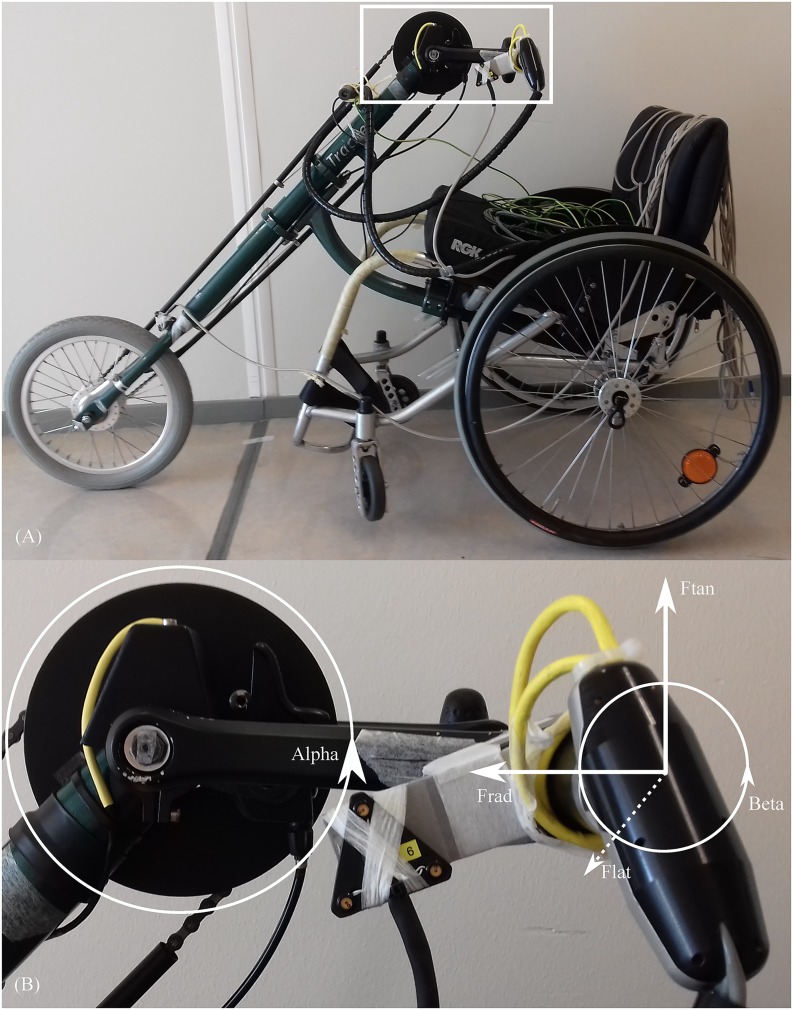
Handcycle and coordinates system.(A) Attach-unit handcycle used in current study with (B) the according 3D coordinates system in the left handlebar. Alpha = angle between crank and axis. Beta = angle between handle and crank. Frad is positive directed towards crank axis, Flat is positive directed leftwards (out of the paper) and Ftan is positive directed counterclockwise.